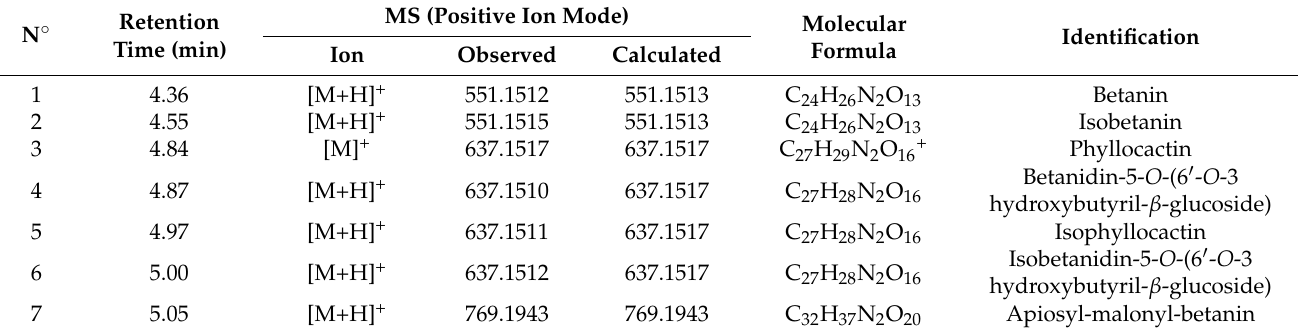
Table 3. Betacyanins identified by